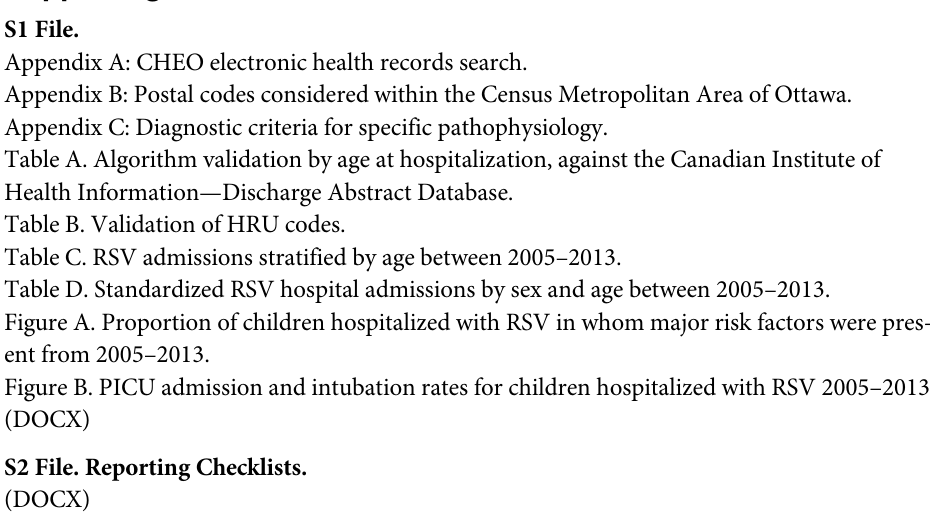
Table A. Algorithm validation by age at hospitalization, against the Canadian Institute of Health Information — Discharge Abstract Database. Table B. Validation of HRU codes. Table C. RSV admissions stratified by age between 2005 – 2013. Table D. Standardized RSV hospital admissions by sex and age between 2005 – 2013. Figure A. Proportion of children hospitalized with RSV in whom major risk factors were pres- ent from 2005 – 2013. Figure B. PICU admission and intubation rates for children hospitalized with RSV 2005 –